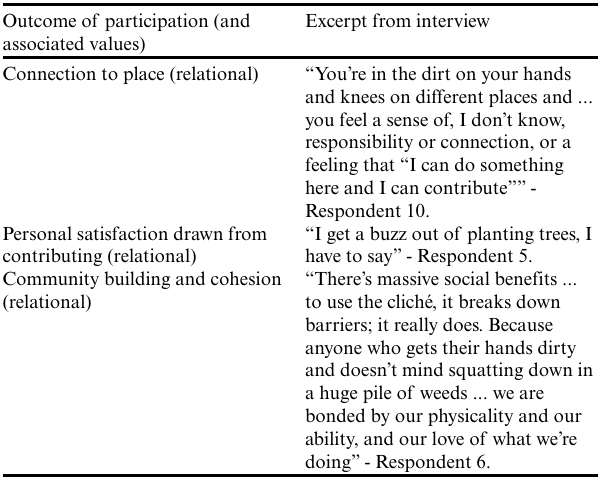
Table 5 . Outcomes of